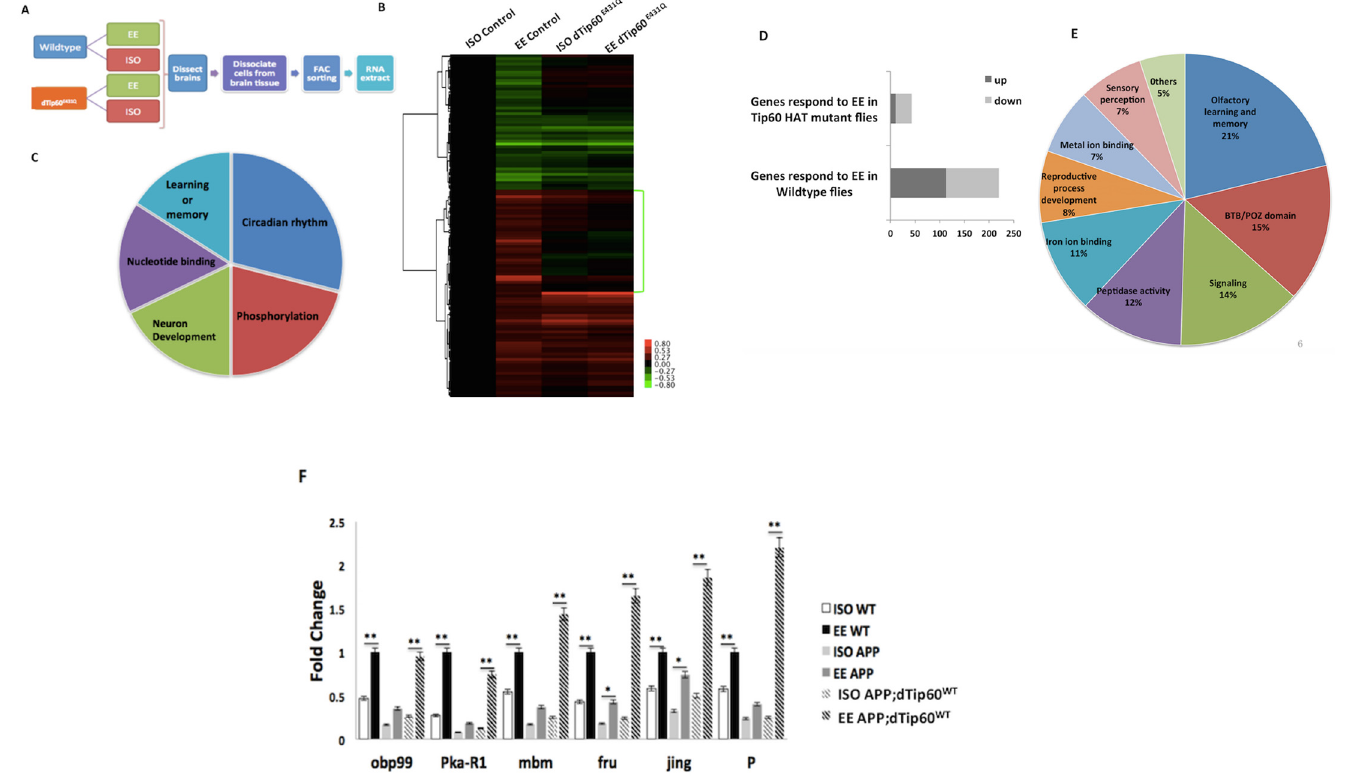
Fig 3. Tip60 promotes EE neuroadaptative transcriptional benefits under APP induced neurodegenerative conditions. (A) Experiment schematic for the microarray analysis. (B) The hierarchical cluster of the 220 genes differentially regulated in response to EE in the wild-type control flies (corrected P-value < 0.05, FC > 1.3) reveals an impaired transcriptional response in Tip60 HAT mutant flies. (C) Pie diagram showing GO term associated enrichment in each of the major function categories identified in the analysis. (D) Number of genes that are up-regulated (dark gray) and down-regulated (light gray) in response to EE in control and Tip60 HAT mutant fly MB neurons with FC > 1.1. (E) Function analysis on the selected gene group (highlighted on heatmap). This subset of genes is not significantly misregulated in comparison to WT under ISO condition, and is not responsive to EE induced neuroadaptive transcriptional benefits. (F) Quantitative RT-PCR validation of representative gene targets in control, APP and APP;dTip60 WT flies under ISO and EE conditions for EE-mediated transcriptional regulation on the representative genes. qPCR was performed using RNA isolated from fly heads. Histogram represents fold change in gene expression using ΔΔ Ct method with RP49 as the internal control. Student t-test was used to determine statistical significance between different housing conditions within the same genotype. ** P < 0.01, * P < 0.05. Error bars indicate SEM.